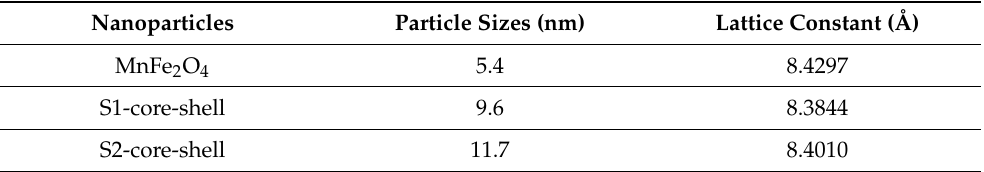
Figure 2. ( a ) XRD of the core-shell nanoparticles S1 and S2. ( b ) Shift in the highest intensity peak (311) of the S1 and S2 nanoparticles. Table 1. The list of lattice constants for the core-shell and individual phases of the nanoparticles.